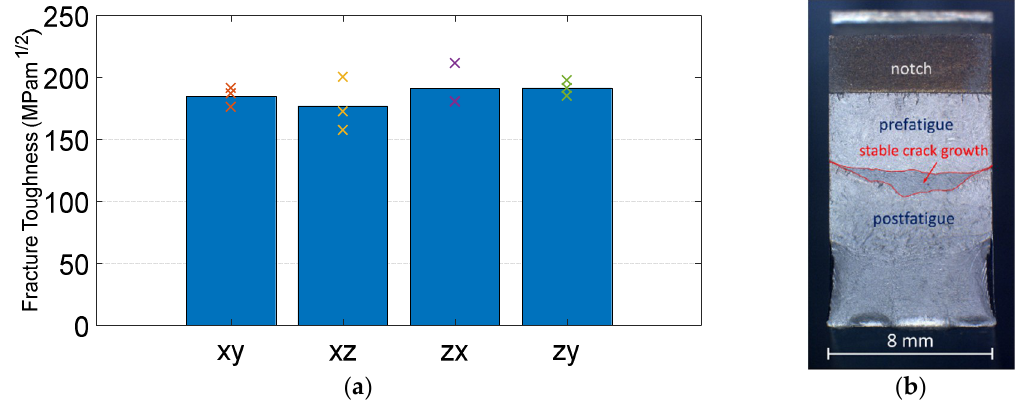
Figure 10. ( a) Fracture toughness K JIC for three samples per orientation of the notch; ( b ) fracture surface of specimen #35.